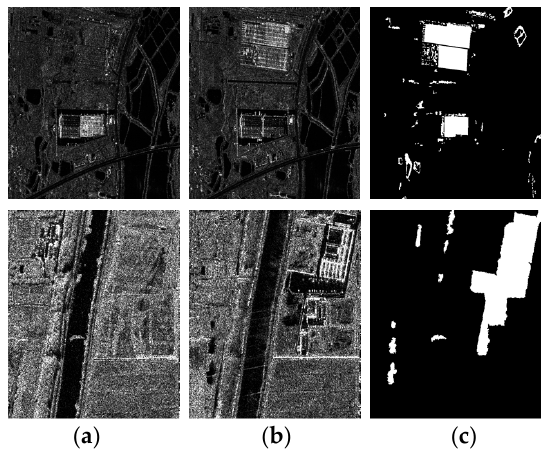
Figure 8. SAR data sets. ( a ) Image T1. ( b ) Image T2. ( c ) Reference change map.